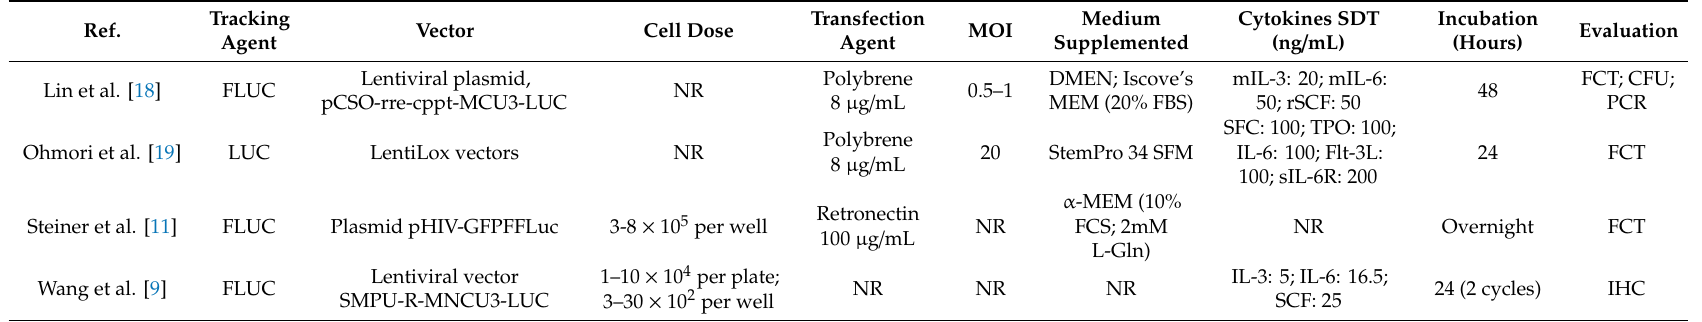
Table 2. Luciferase transduction in hematopoietic stem cells.